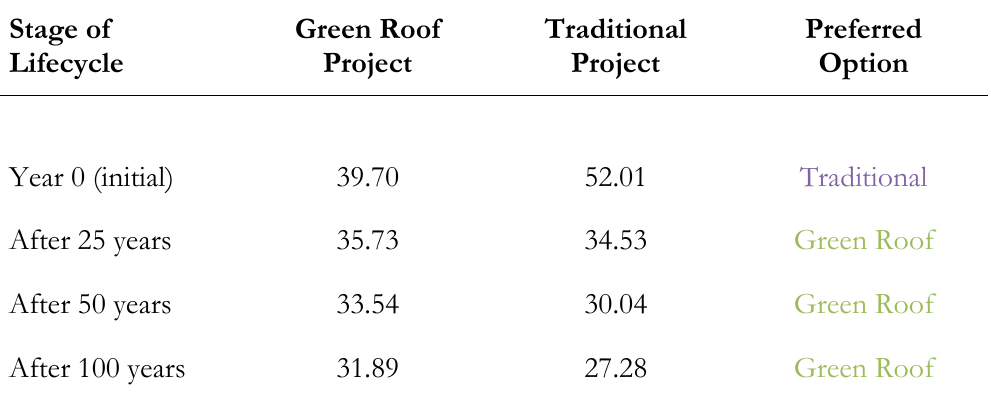
Table 2: Overall performance assessment Stage